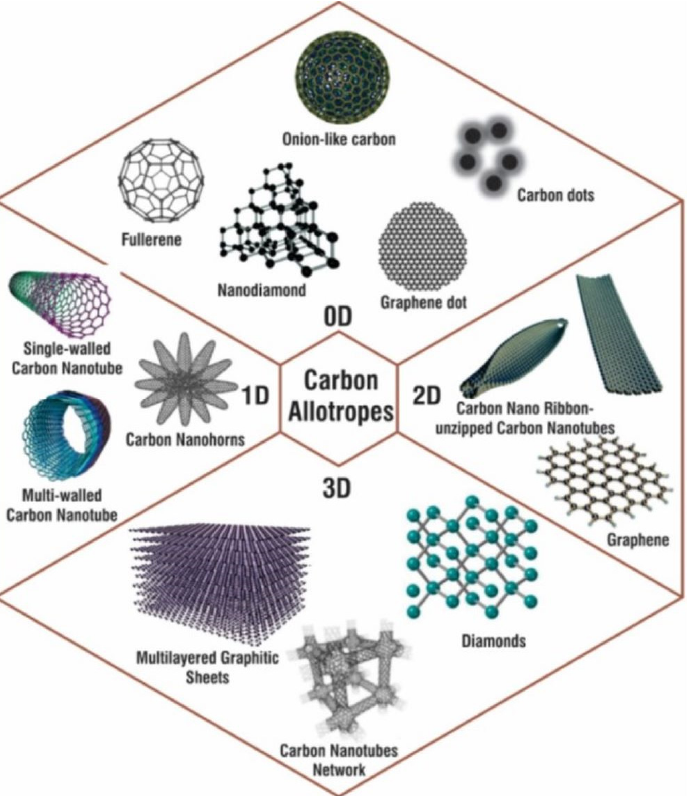
Figure 2. Classification of nanomaterials of carbon allotropes based on their dimensionality. Adapted with permission from Gaur et al. [85] . Copyright (2021) MPDI.